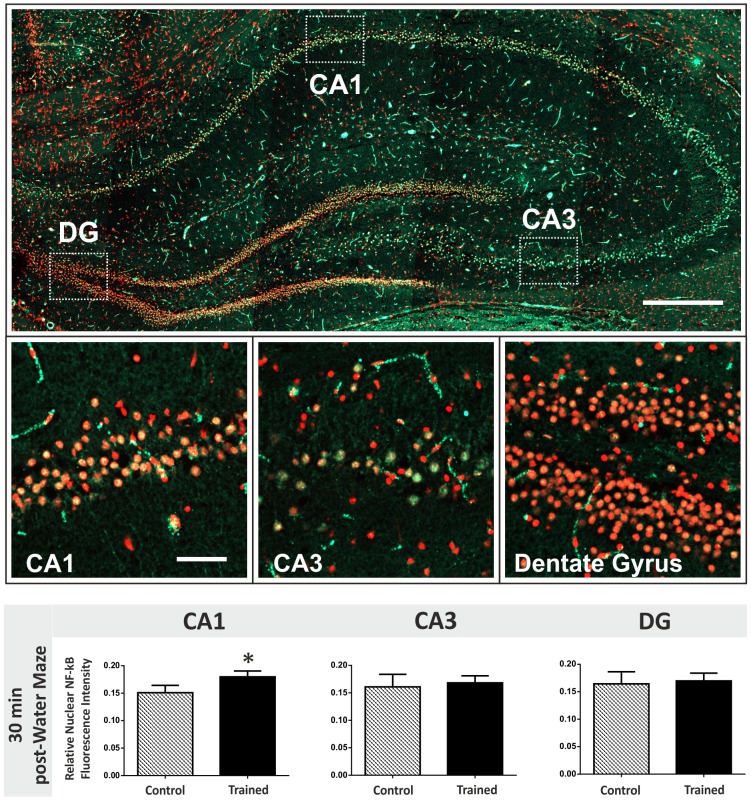
Changes in nuclear NF-κB levels 30 min post-spatial learning in the hippocampus.Top panel: Coronal section through the rat dorsal hippocampus (approx. −3.3 mm with respect to Bregma) immunofluorescently-labelled for the active form of the p65 subunit of NF-κB. Nuclei are stained red using propidium iodide and NF-κB labelled green using a FITC-conjugated secondary antibody. The white boxes represent the three regions of the hippocampal neuronal network that were analysed throughout this study. Scale bar = 400 µm. Middle panel: High-magnification images (40X) of the CA1, CA3 and DG illustrated by white boxes in the top montage. Scale bar = 50 µm. Bottom graphs: Levels of activated nuclear NF-κB fluorescence were measured in the rat hippocampus 30 min after water maze training ceased. CA1, CA3 and dentate gyrus cell populations were compared for passive control and trained rats. There is an up-regulation in activated nuclear NF-κB in the CA1 region (*two-tailed Student's t tests, p value<0.05).